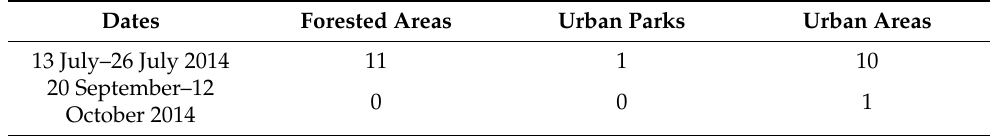
Table 3. Total number of L. zampa recorded through trail surveys across forested areas, urban parks, and urban